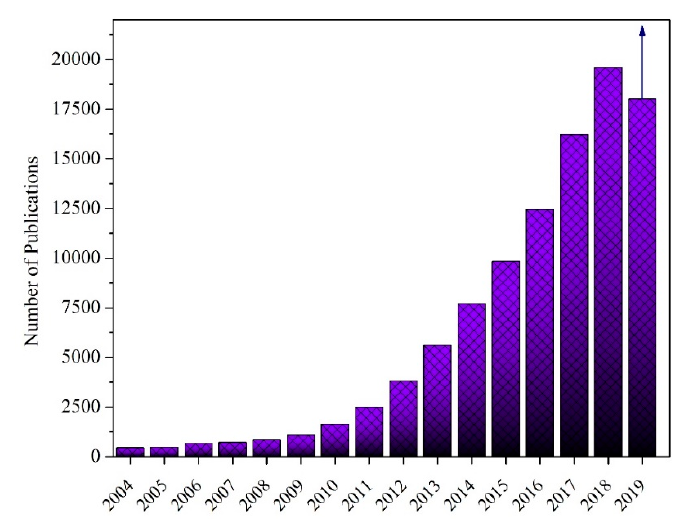
Figure 1. Number of publications in web of science database with the keyword of graphene as a function of year.